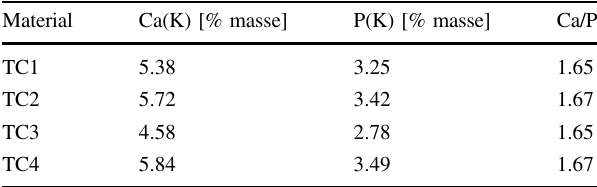
Table 2 EDS analysis for different tri-composite